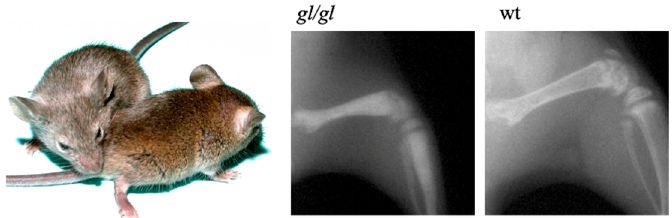
Figure 1. Grey coat color in gl / gl mice (left) and representative X-rays of osteopetrotic gl / gl bone compared to agouti wild-type (wt) littermate.